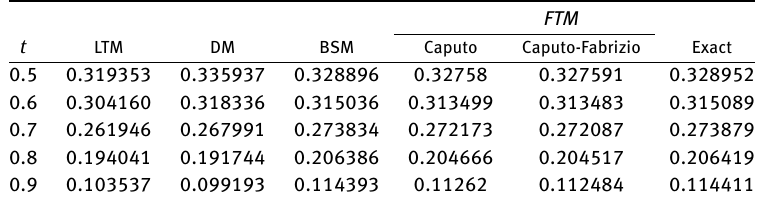
Table 4: Comparison of the numerical solutions of the equation in example 5.3 with α = 2 .